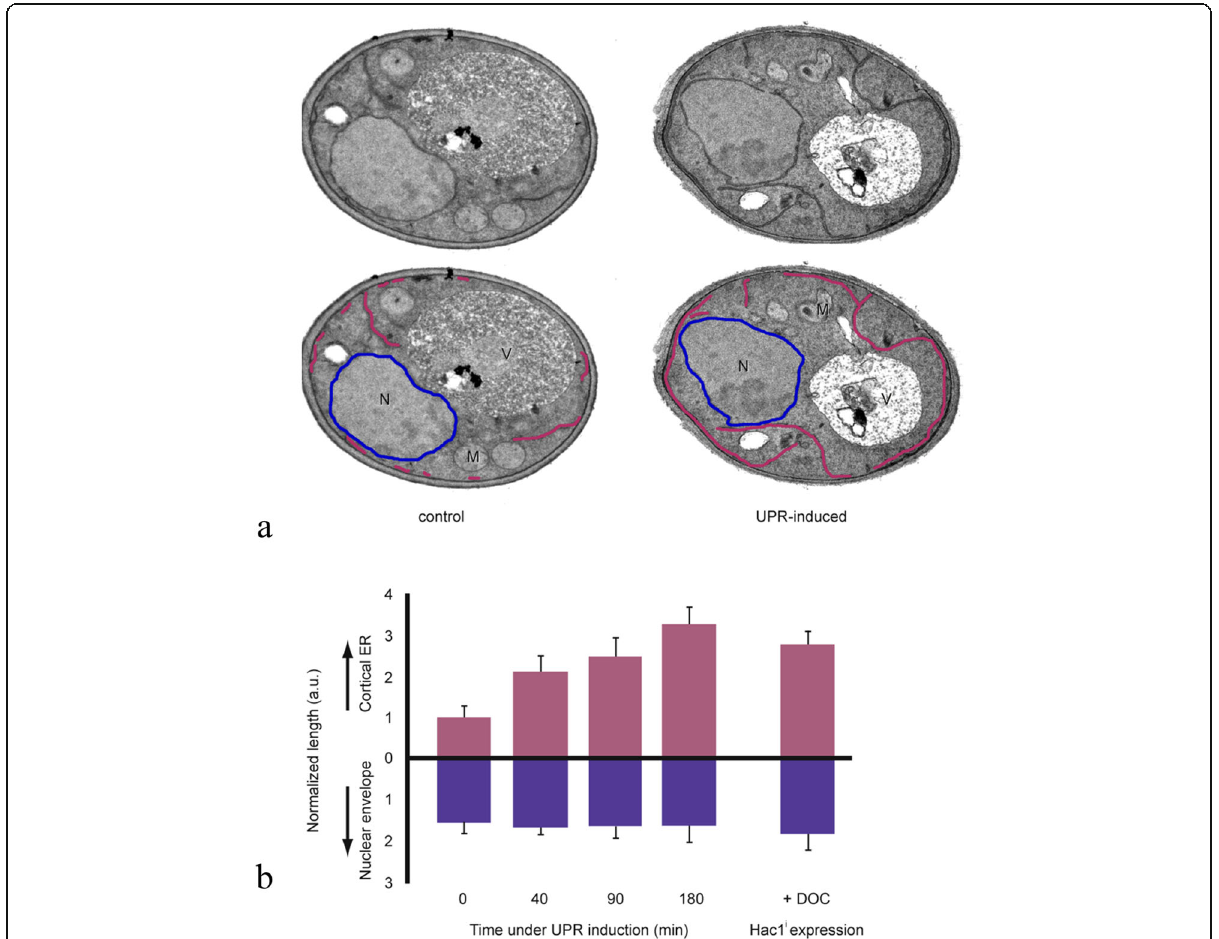
Fig. 2 ER elongation after UPR induced stress. a Determination of ER elongation in cells before (control) and after UPR stress (UPR-induced). TEM examinations of thin sections of a control and an UPR-induced cell were magnified to a resolution of 140 nm (upper images) in which the cortical ER was outlined in magenta, and the nuclear envelope outlined in blue (lower images). Cursory glance reveals UPR stress causes ER elongation with inward displacement of the ER away from the plasma membrane. b Quantification of the cortical ER and nuclear envelope after UPR induction. Length of the ER (as traced in a ) was measured and divided by area of the section generating a normalised length (a.u.). Data plotted relative to time 0. Measurement for each time point corresponds to mean of 25 independent cells. ER , Endoplasmic reticulum; TEM , Transmission electron microscopy; UPR , Unfolded protein response. Adapted with permission from Bernales et al.